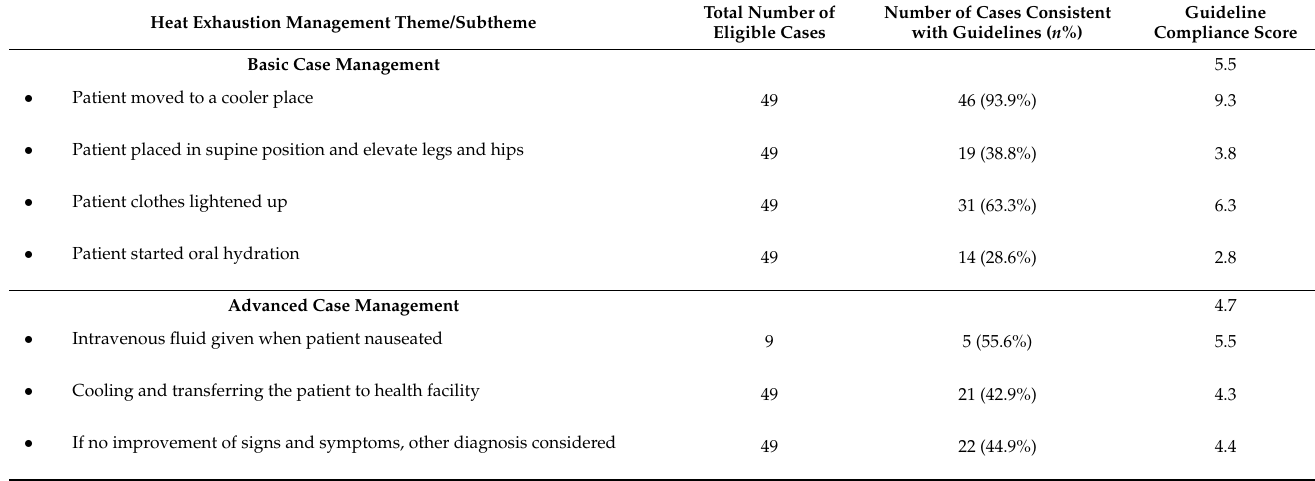
Table 2. Heat exhaustion management guidelines compliance scores for the heat exhaustion cases ( n = 98).